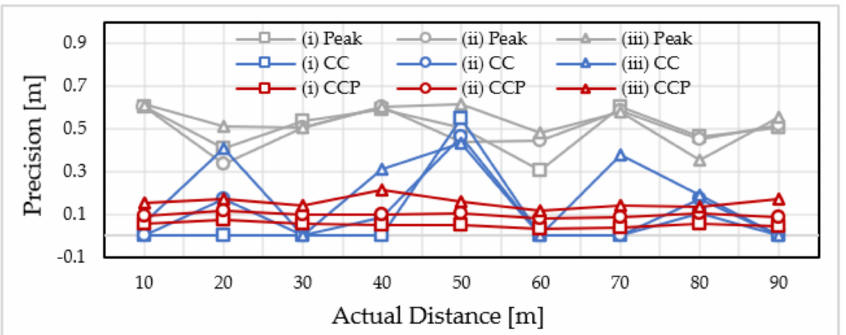
Figure 17. The precisions of the peak, CC, and CCP methods are determined in different background light